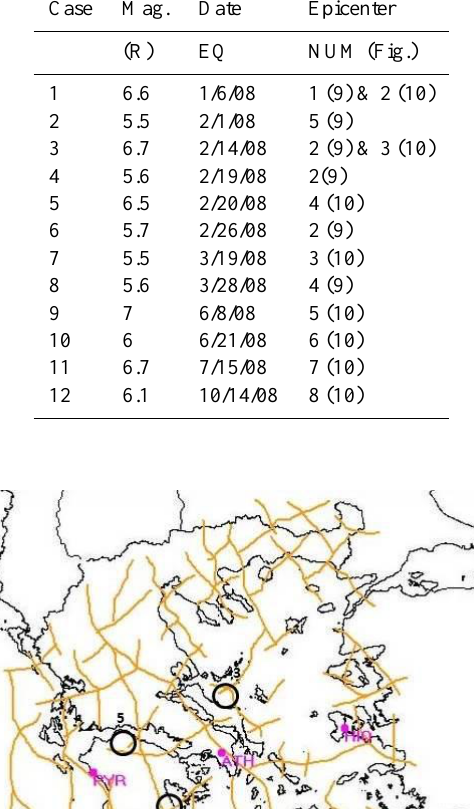
Table 1. List of EQs registered in Greece in 2008.